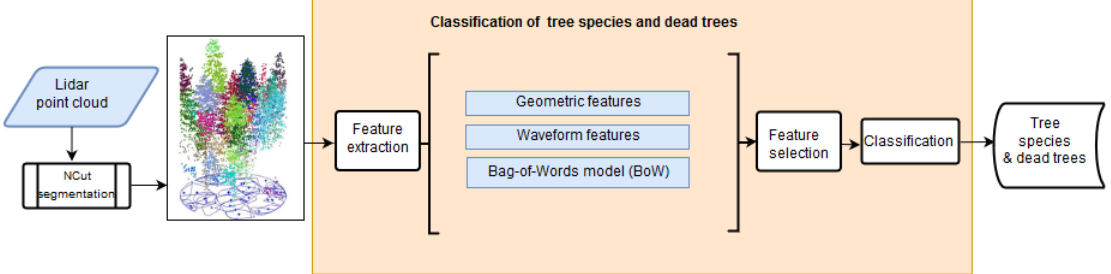
Figure 4. Overview of the approach for classification of tree species and standing dead